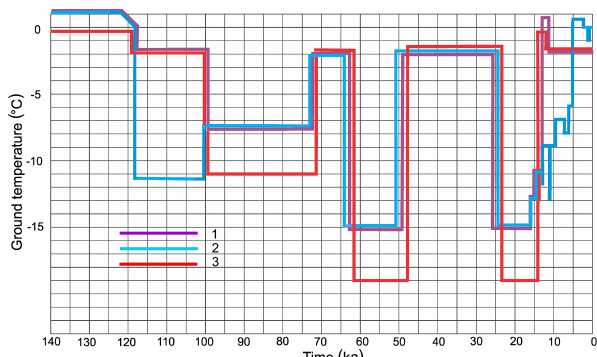
Figure 5. Paleotemperature curves for the periglacial subaerial part of the shelf: 1 – southwestern shelf part (SW), 80m isobath; 2 – southwestern shelf part (SW), 5m isobath; 3 – northeastern shelf part (NE), 120m isobath.